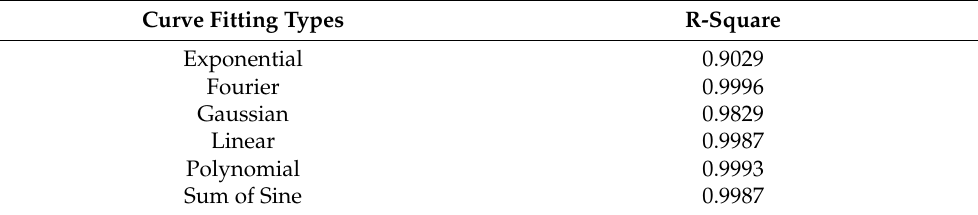
Figure 8. Example of a database of the model with curve-fitting in various forms. Table 3. Example of the R-square values of the curve-fitting types.